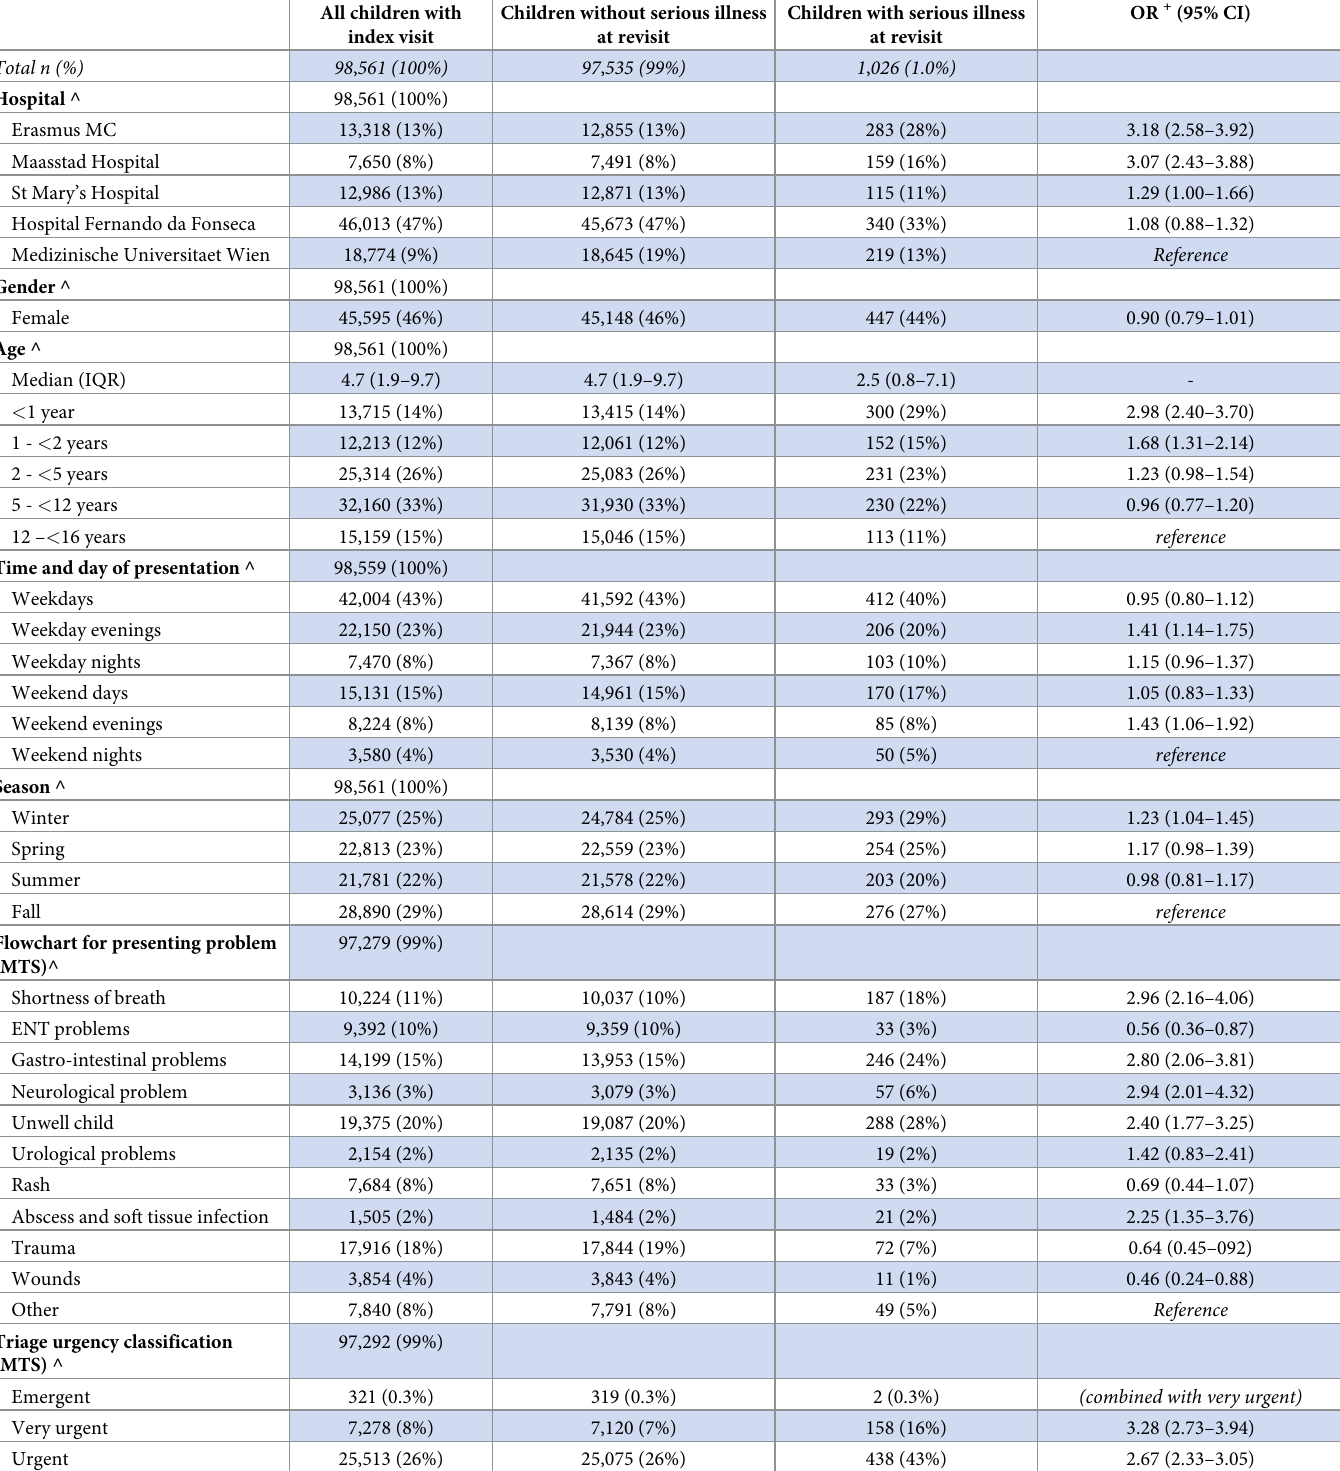
Table 2. Characteristics of children at the time of their index visit who had and did not have a revisit with serious illness (n =